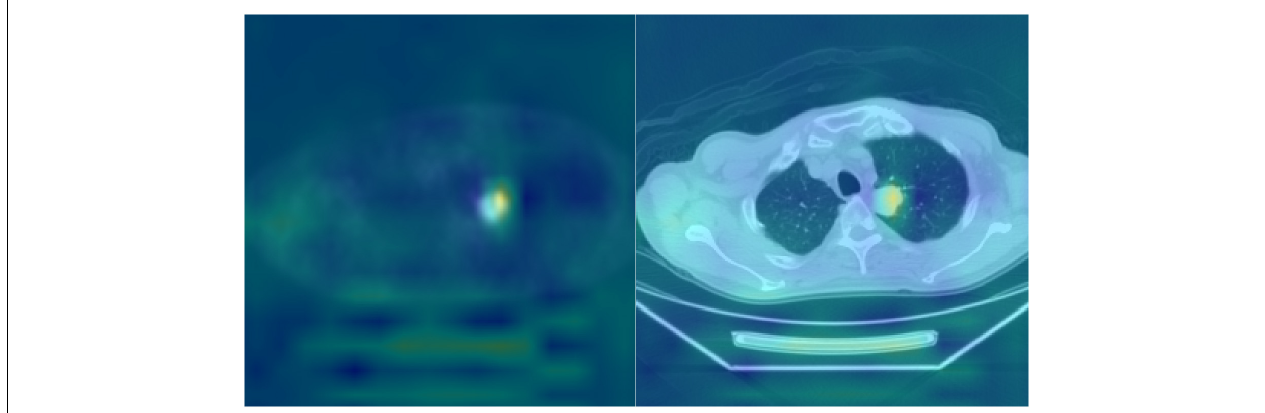
FIGURE 6 | Heatmap visualization of the HRNet-automated model. The highlighted (e.g., red) area on the heat map were used to indicate the portions/pixels of an image that have the greatest contribution to the output of the model. The heated area matched quite well with the actual locations of pulmonary nodules on the DICOM PET-CT images and the clinical records, which potentially serves as a beneficial clinical tool for patient treatment planning.